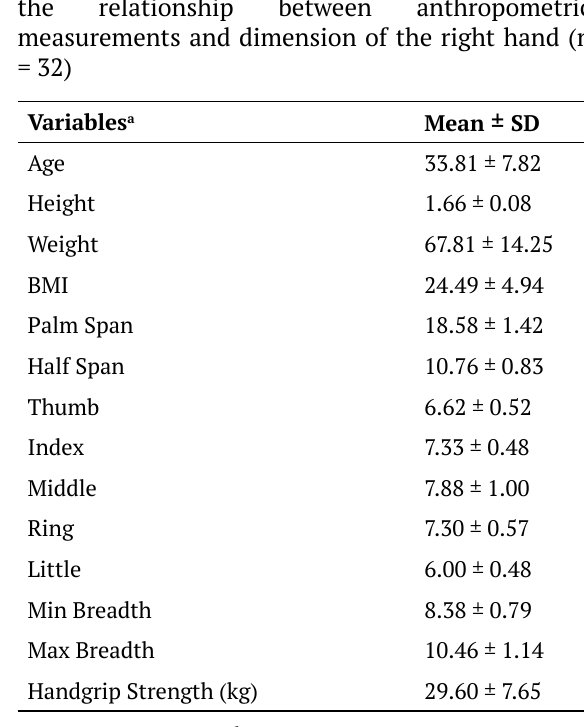
1. Anthropometric characteristics for the relationship between